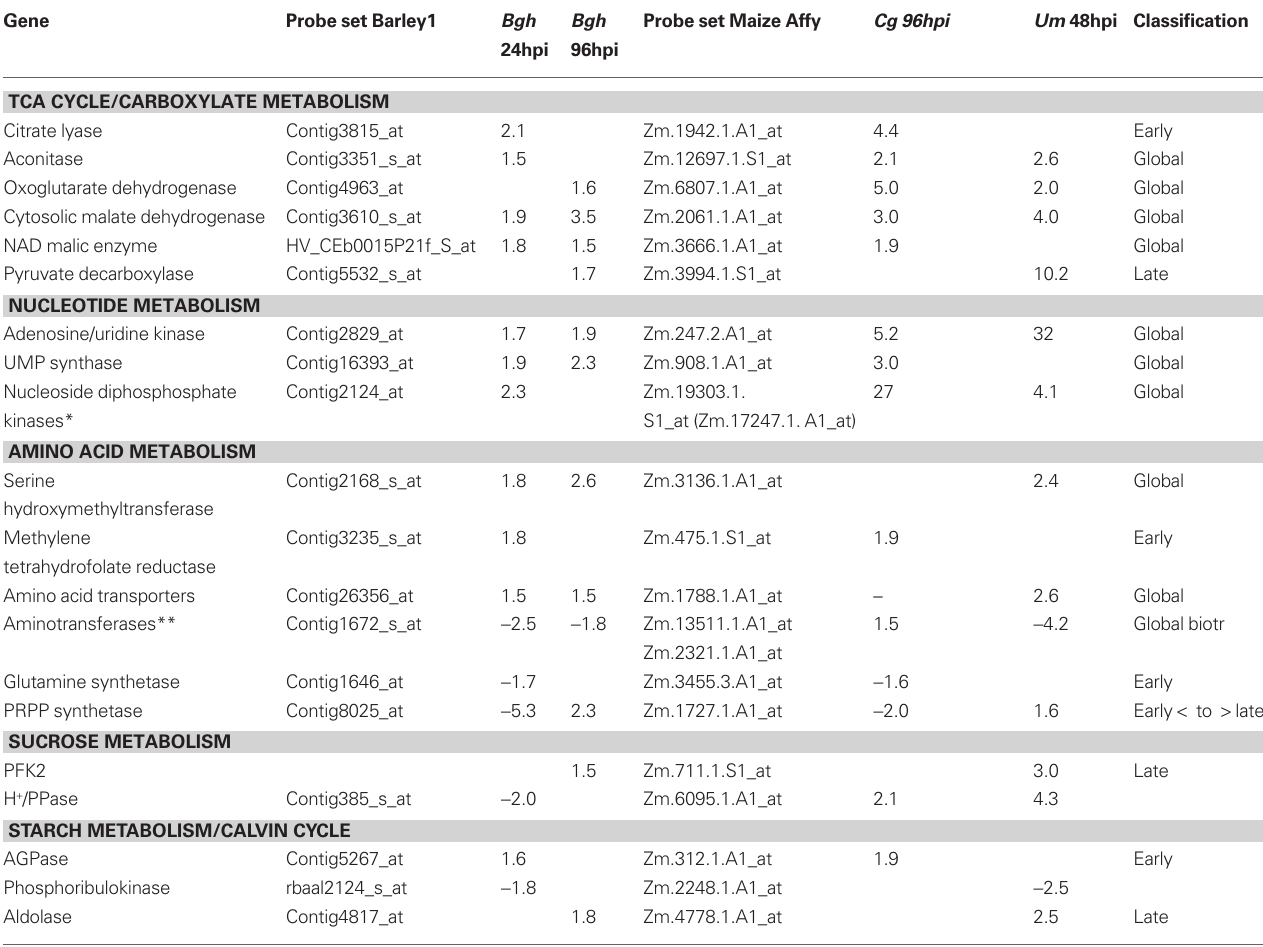
Table 4 | consistent transcriptional changes among the pathosystems.